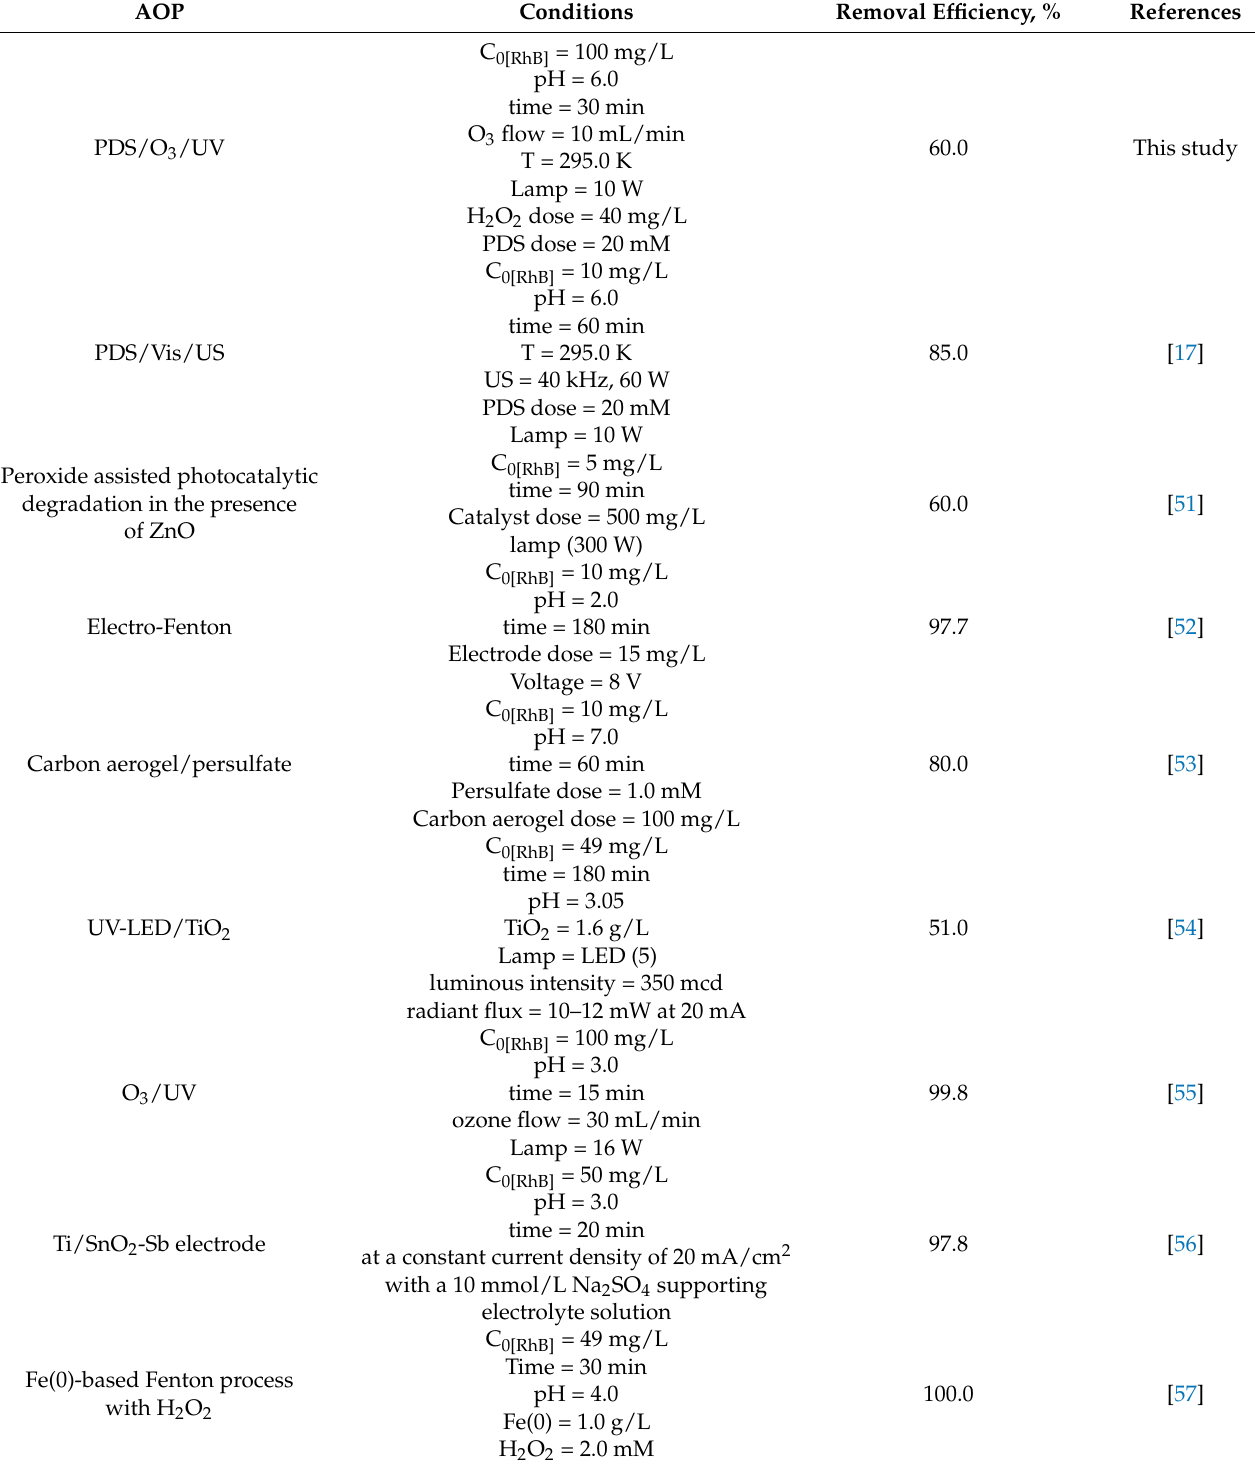
Table 5. The summary of different AOPs applied for RhB